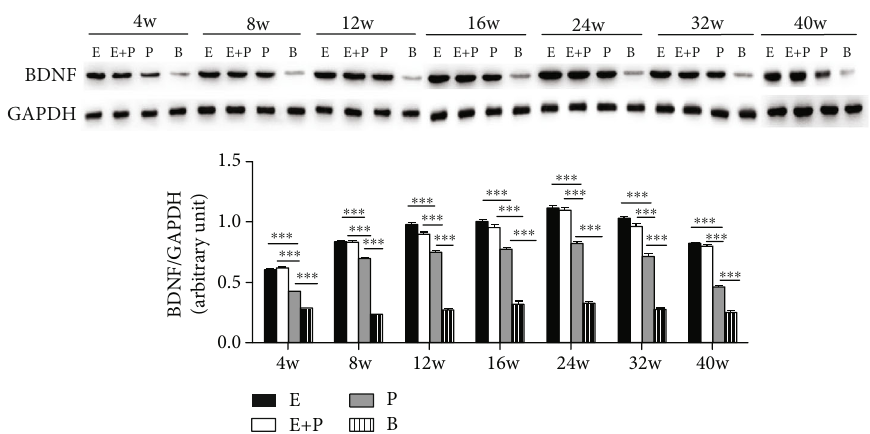
Figure 3: Western blot analysis of BDNF protein levels (normalized to GAPDH) in three groups in the left hemispheres. E: entire root group; E+P: entire root+posterior division group; P: posterior division group; B: blank control group. Data are expressed as mean ± SD ; ∗∗∗ P < 0 : 001 (one-way ANOVA followed by LSD).